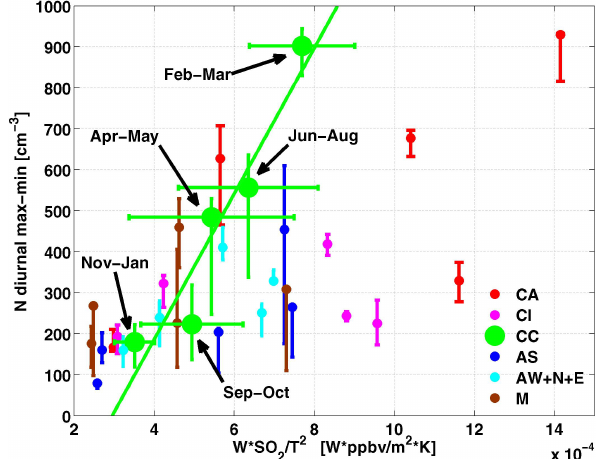
Fig. 10. Difference between the diurnal maximum and minimum in median N values measured at the JFJ versus W · SO 2 / T 2 measured at Payerne (Swiss plateau) for different SYNALP weather types, and periods of the year. The upper and lower confidence limits on the y-axis are calculated with a non-parametric estimator, where the x-axis error bars are calculated with standard error propagation of the instrument uncertainties. The x-axis error bars are plotted only for CC for the purpose of